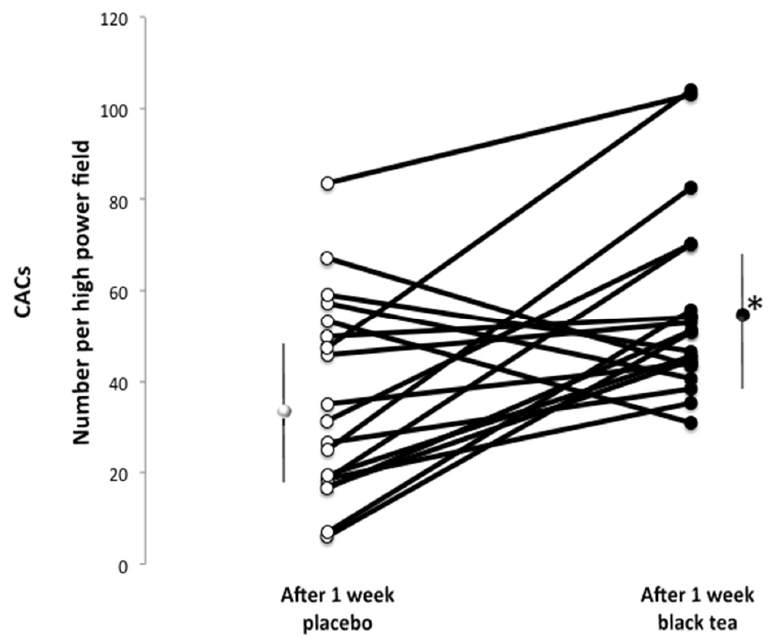
Figure 2. Absolute numbers of functional circulating angiogenic cells (CACs) per high ‐ power field fluorescence microscopy ( × 20) before and after 1 week of treatment with placebo ( white ) and black tea ( black ) administration. Data are presented as LSmeans ± SE. Vertical lines indicate SD, and asterisks (*) indicate significant differences with respect to the placebo phase. Differences are considered significant when p < 0.05.